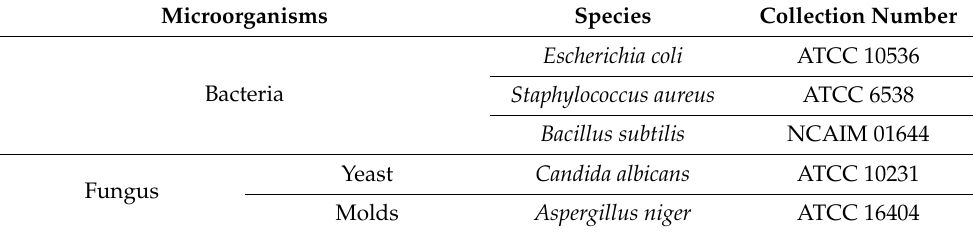
Table 6. Biological